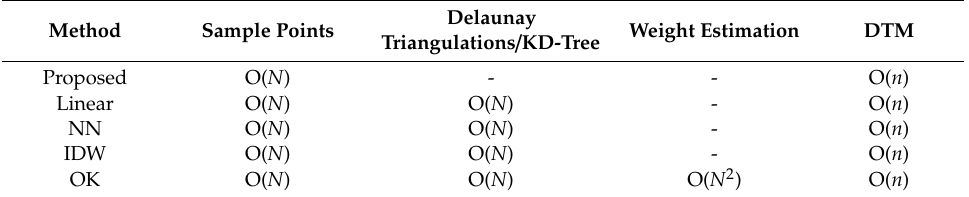
Table 3. Space complexities of the proposed method and the classical interpolation methods for DTM